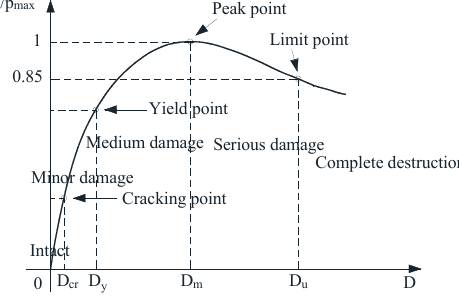
Figure 3. Dipiction of the pier damage states.